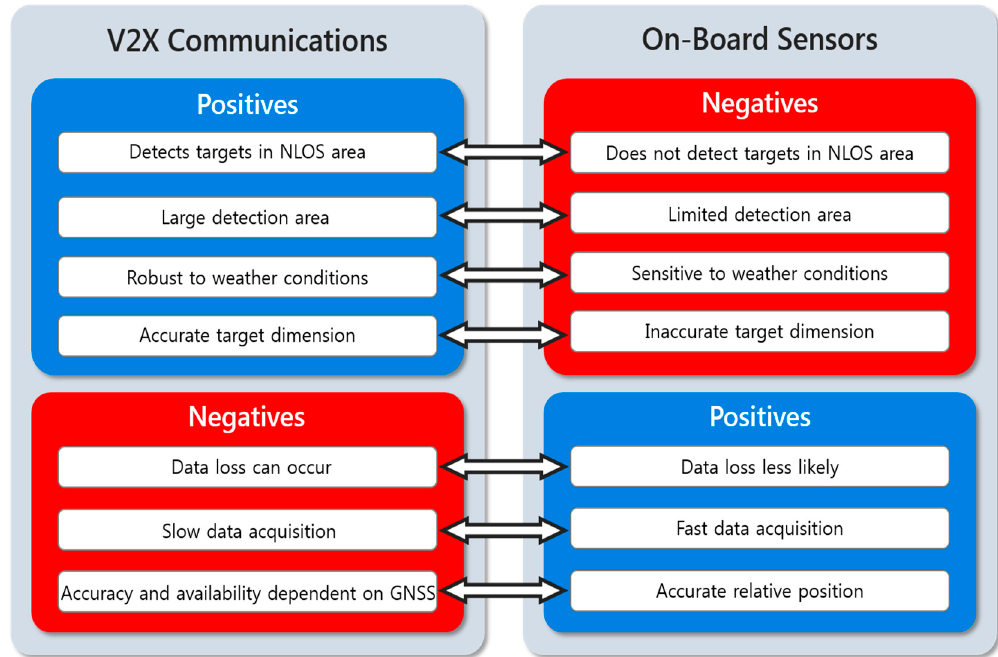
Figure 1. Positive and negative characteristics of perception using vehicle-to-everything (V2X) communications and on-board automotive sensors for remote sensing.